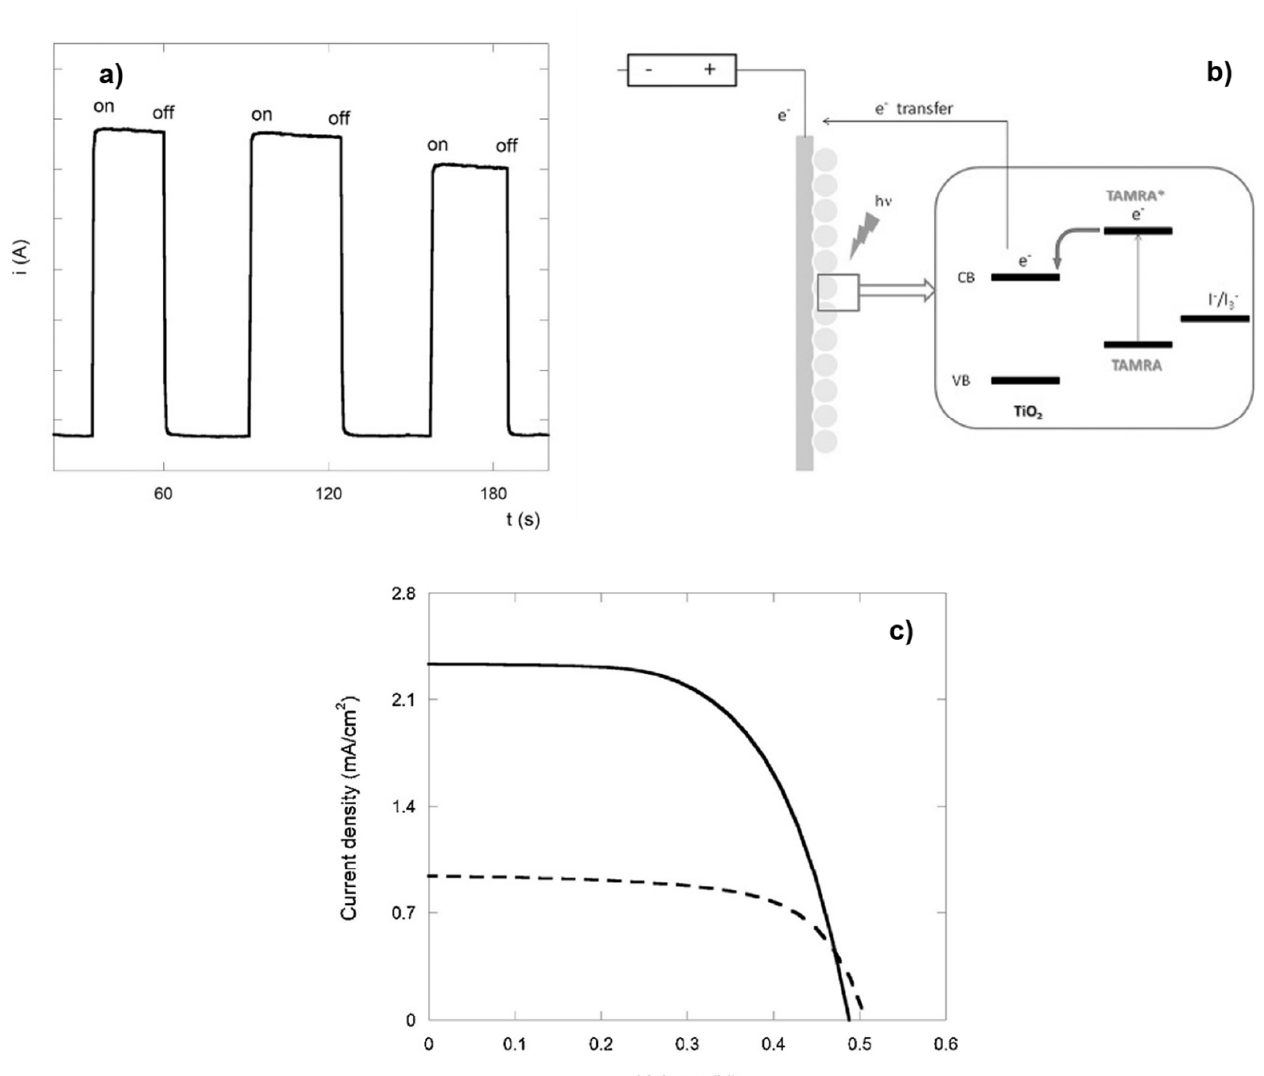
Figure 5. Photocurrent generation experiments performed on the T12 peptide immobilized on a TiO 2 /FTO electrode. ( a ) Photocurrent on-off graphic at 0 V bias potential, under illumination at λ = 550, 560, and 570 nm. ( b ) Scheme of the energy states and of the electron transfer flow responsible for the photocurrent process. ( c ) I-V characteristics of the T12/TiO 2 /FTO electrode (continuous line) and of the bare TiO 2 /FTO electrode (dotted line). Adapted from ref. [89], with permission from Else- vier.